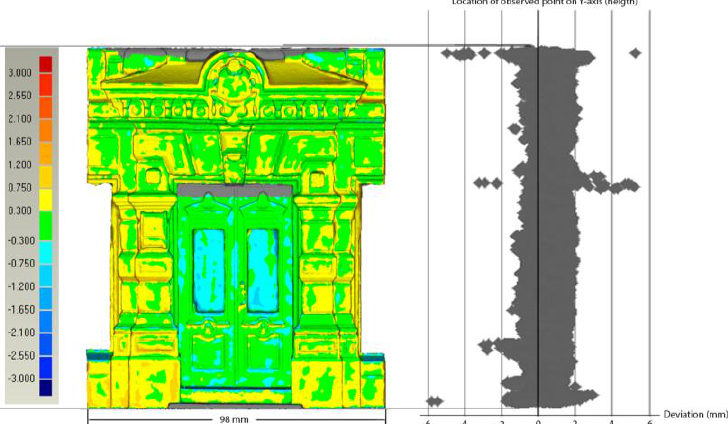
Figure 12. Deviation analysis and scatter of the Façade segment model (Stratasys Prodigy Plus).